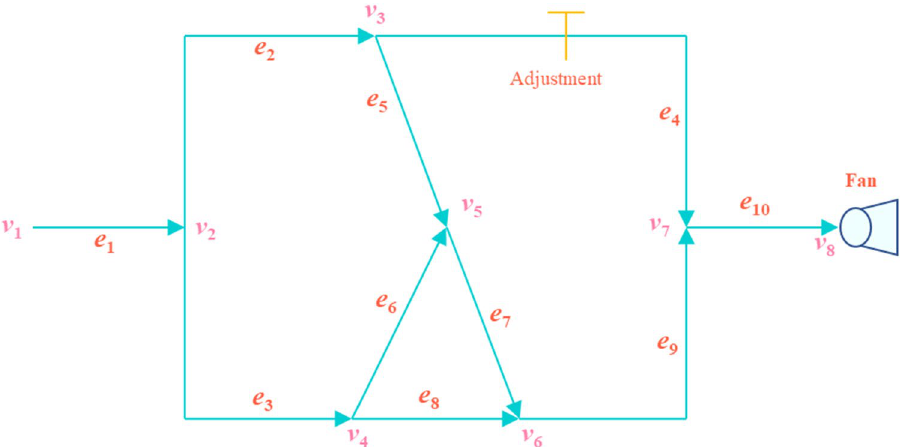
Figure 4. T-shaped angle-joint ventilation network.